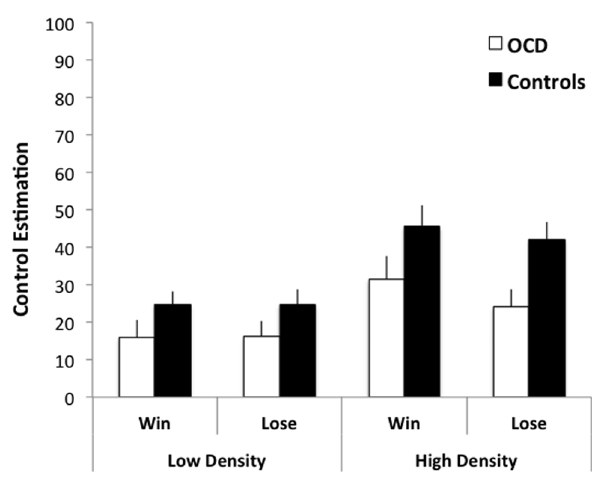
FIGURE 2 | Control estimations by OCD patients and comparison subjects during a zero contingency task. OCD patients’ estimates were overall more realistic than comparison subjects independent of the outcome density (high-65%/low-35%) and valence (gain + 5p/loss − 5p) conditions. Error bars represent standard error of the